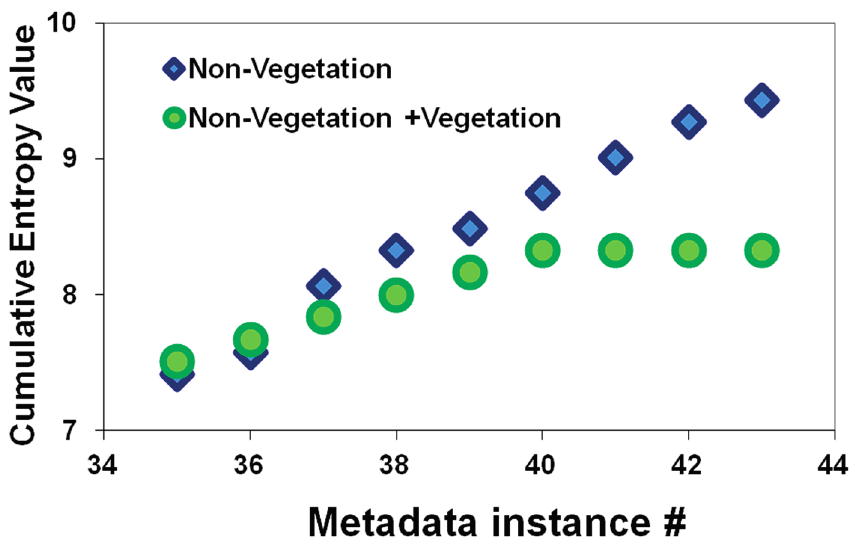
Figure 3. Cumulative entropy for non-vegetation and mixed